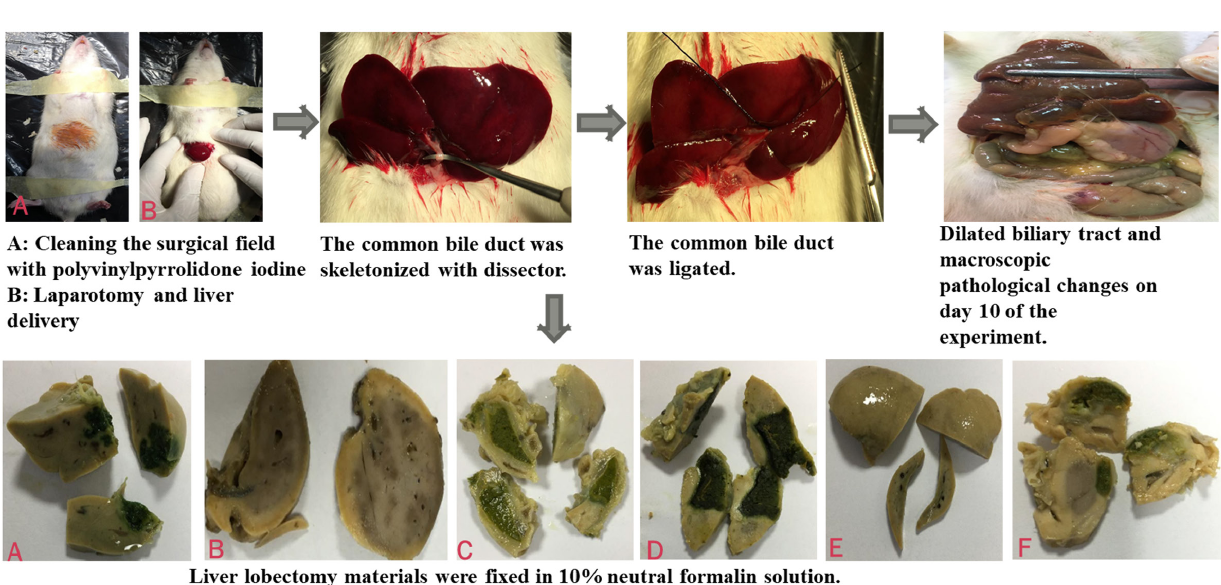
Figure 1. The study chart of the bile duct ligation and lobectomy is seen. (A) Lobectomy sections of control group. (B) Lobectomy sections of sham group. (C) Lobectomy sections of BDL+NAL. (D) Lobectomy sections of BDL+OND. (E-F) Lobectomy sections of Evaluation of Histopathologic Findings All tissue samples were fixed in 10% neutral formalin